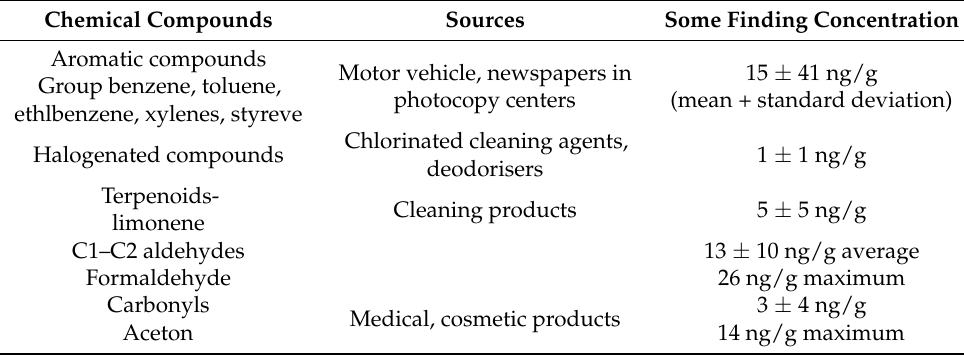
Table 2. Chemical compounds in the air in buildings, their sources and their concentrations